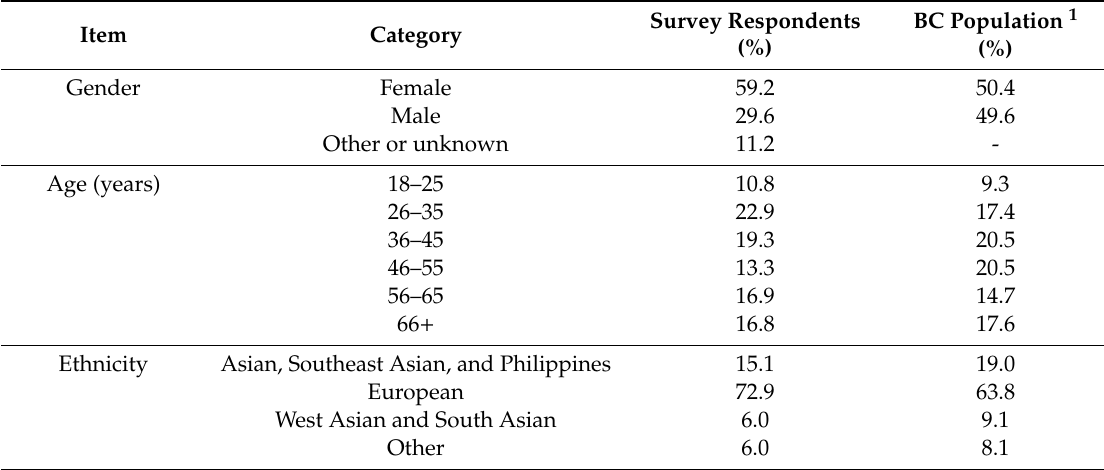
Table 2. Comparison of survey respondents’ demographics ( N = 169) with the general British Columbia